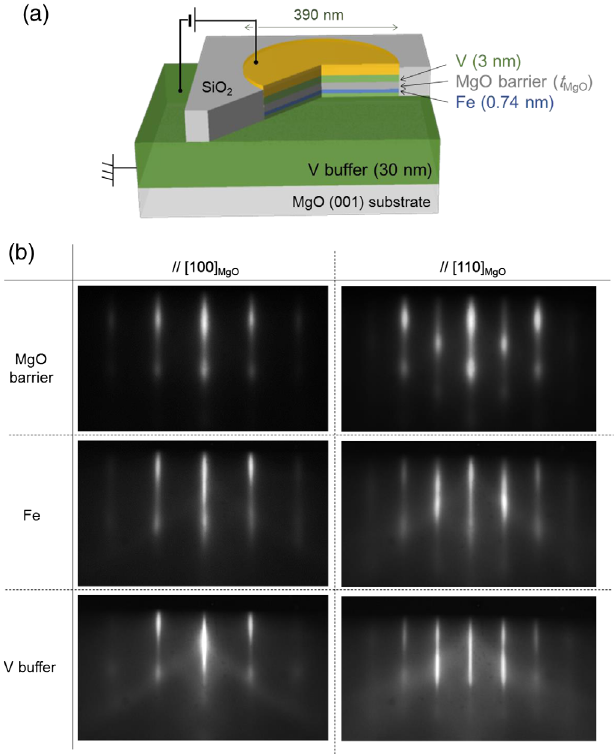
FIG. 1. (a) Schematic illustration of the device structure. (b) In-situ reflection high-energy electron-diffraction images of surfaces of the MgO barrier, Fe, and V